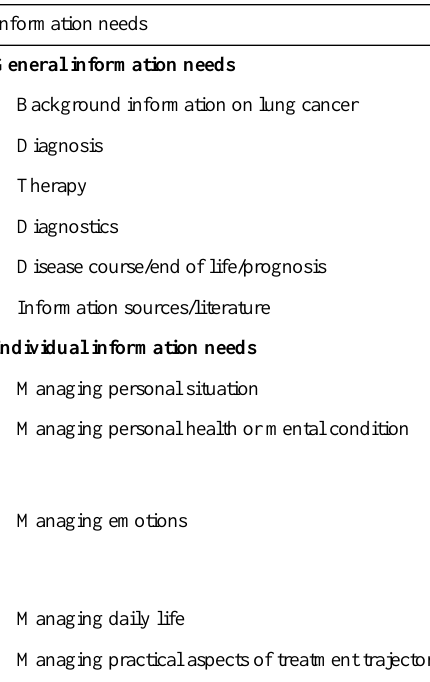
Table 2. Needs of